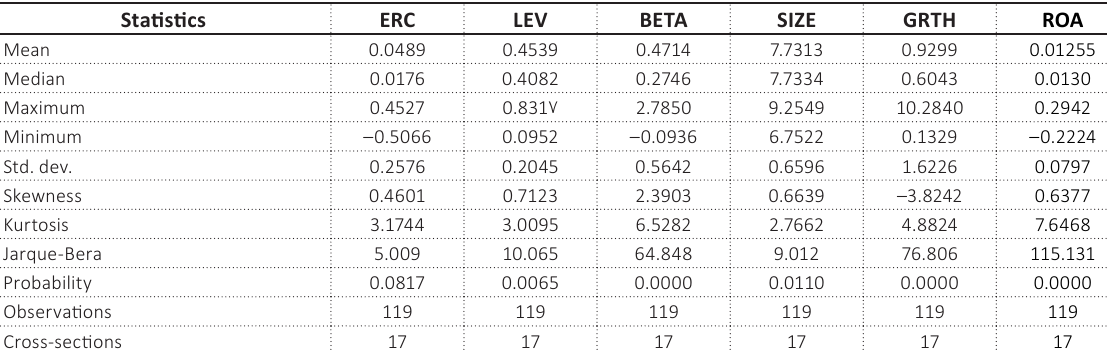
Table 2. Descriptive statistics of the study